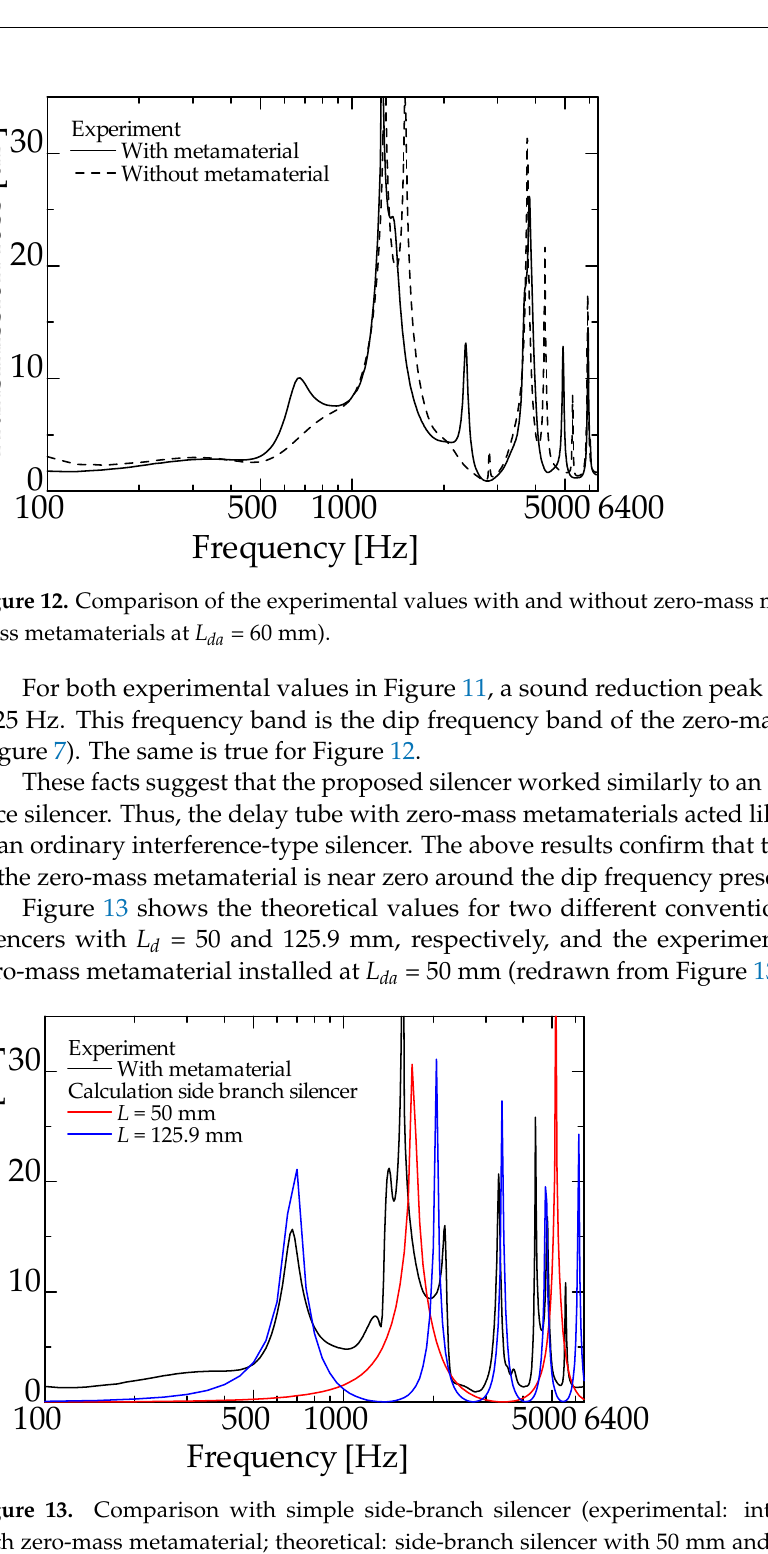
Figure 11. Comparison of the experimental values with and without zero-mass metamaterial (zero- mass metamaterials at L da = 50 mm).